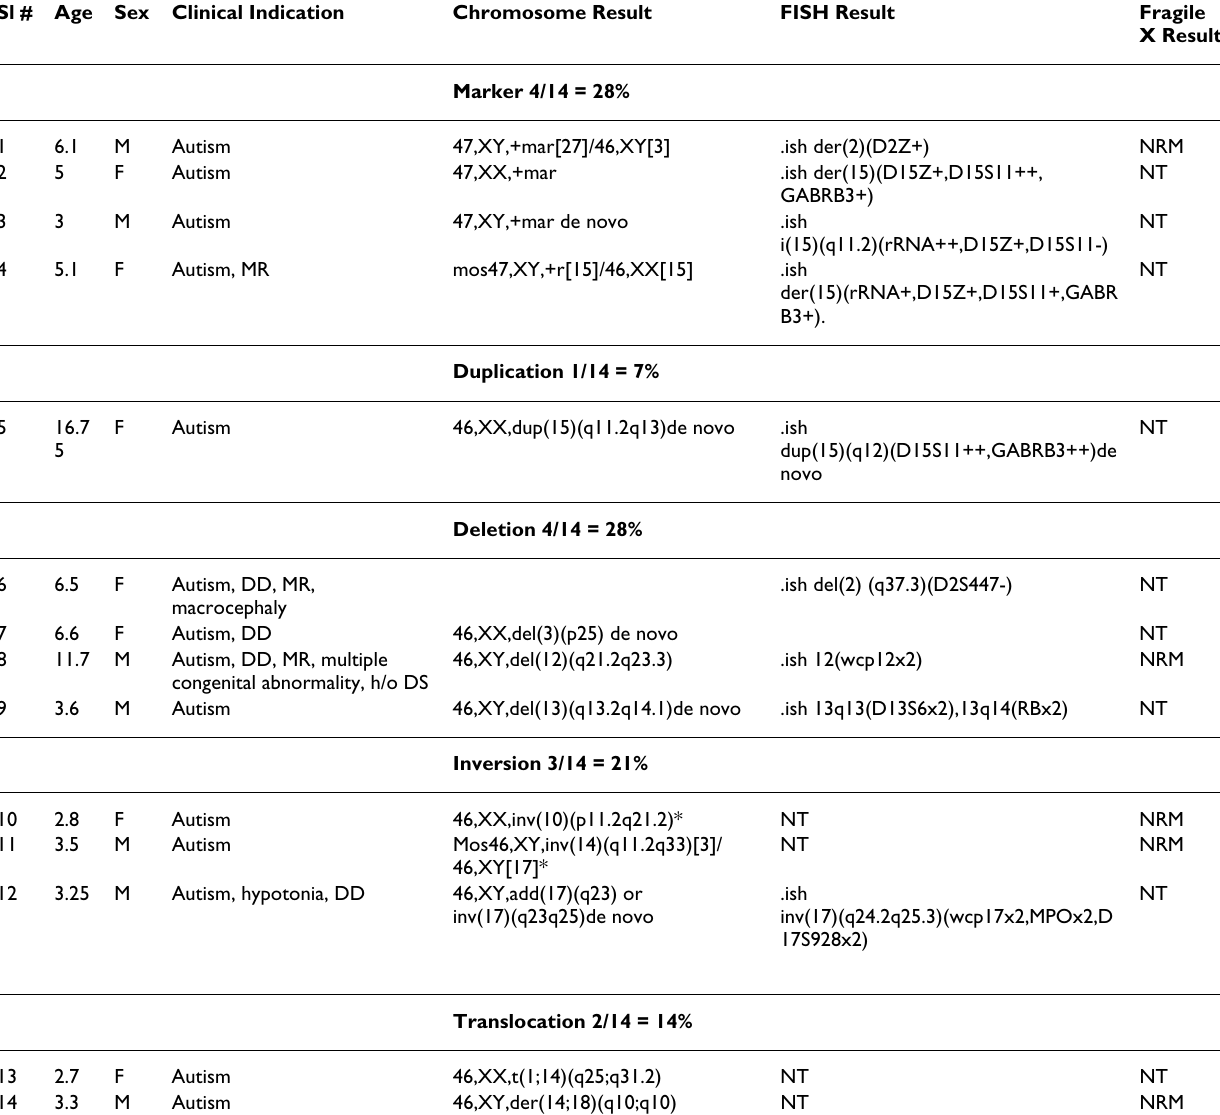
Table 2: The chromosome abnormality found in 3.33 % (14/421) patients with an indication of autism Sl # Age Sex Clinical